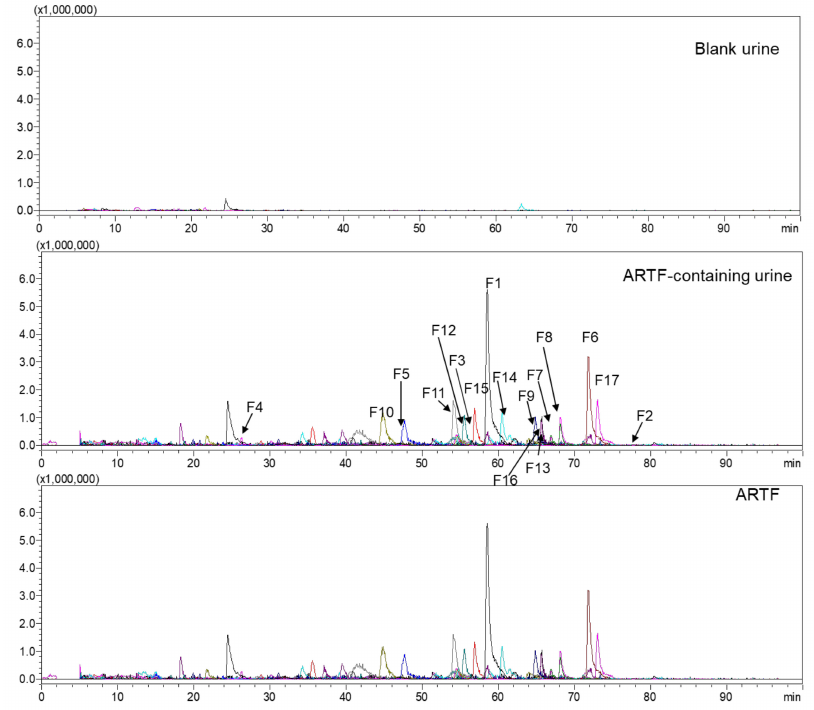
Figure 1. The extracted ion chromatograms (EICs) of original constituents ( F1 – F17 ) in rat urine after administration of Astragali Radix total flavonoid